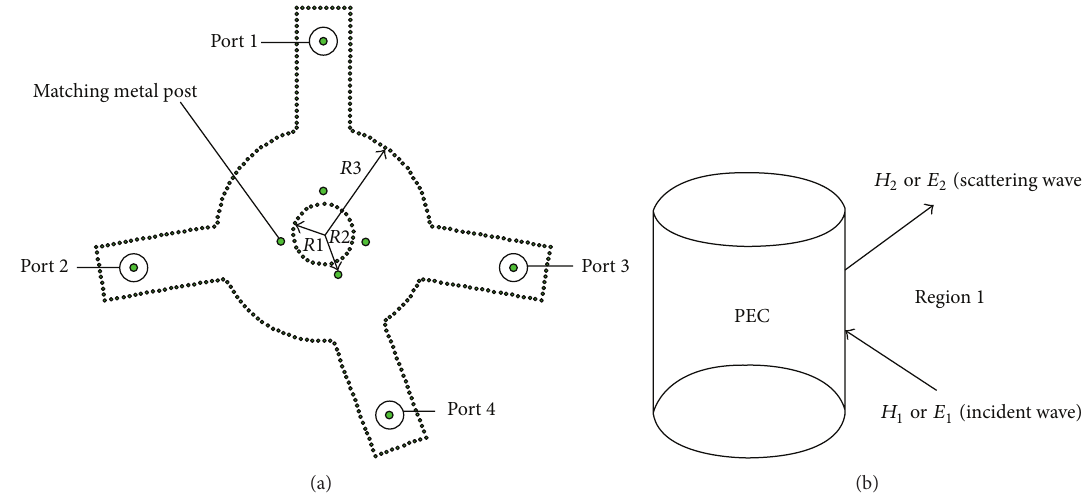
Figure 1: (a) Top view of the proposed rat-race coupler under analysis. (b) One via of rat-race coupler and its related waves.